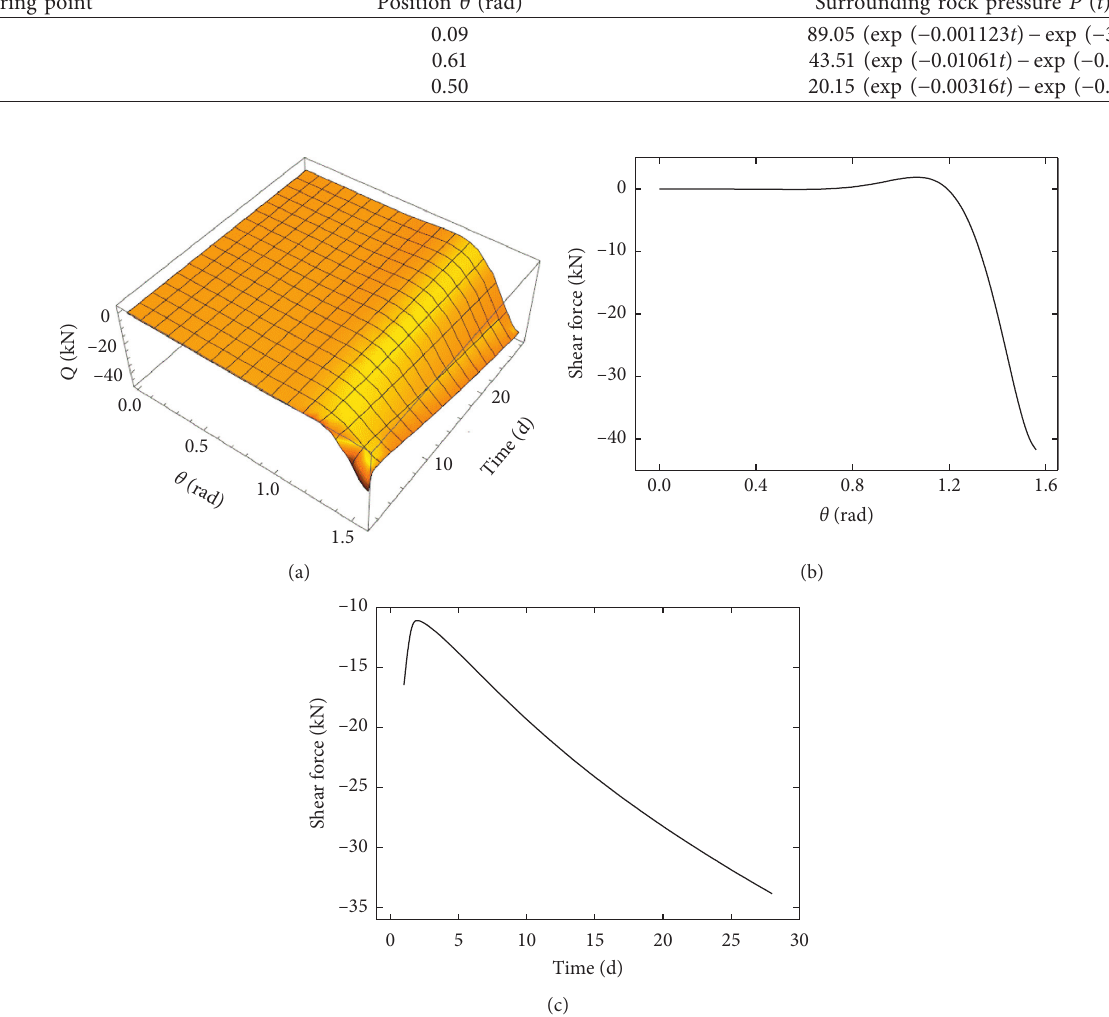
Figure 6: Primary support shear force (kN). (a) Temporal-spatial distribution. (b) t � 28d. (c) θ �